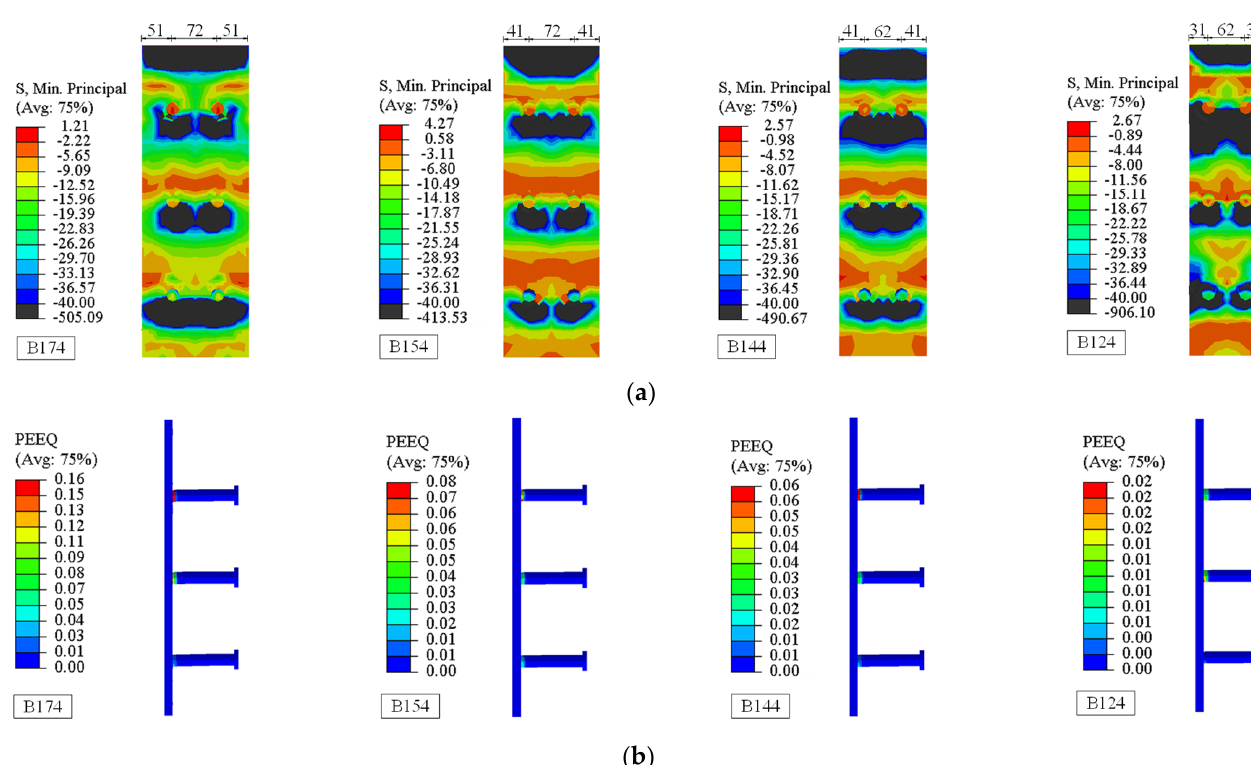
Figure 25. Stress and strain distribution of the specimen at peak load: ( a ) stress distribution of UHPC; ( b ) PEEQ of studs.